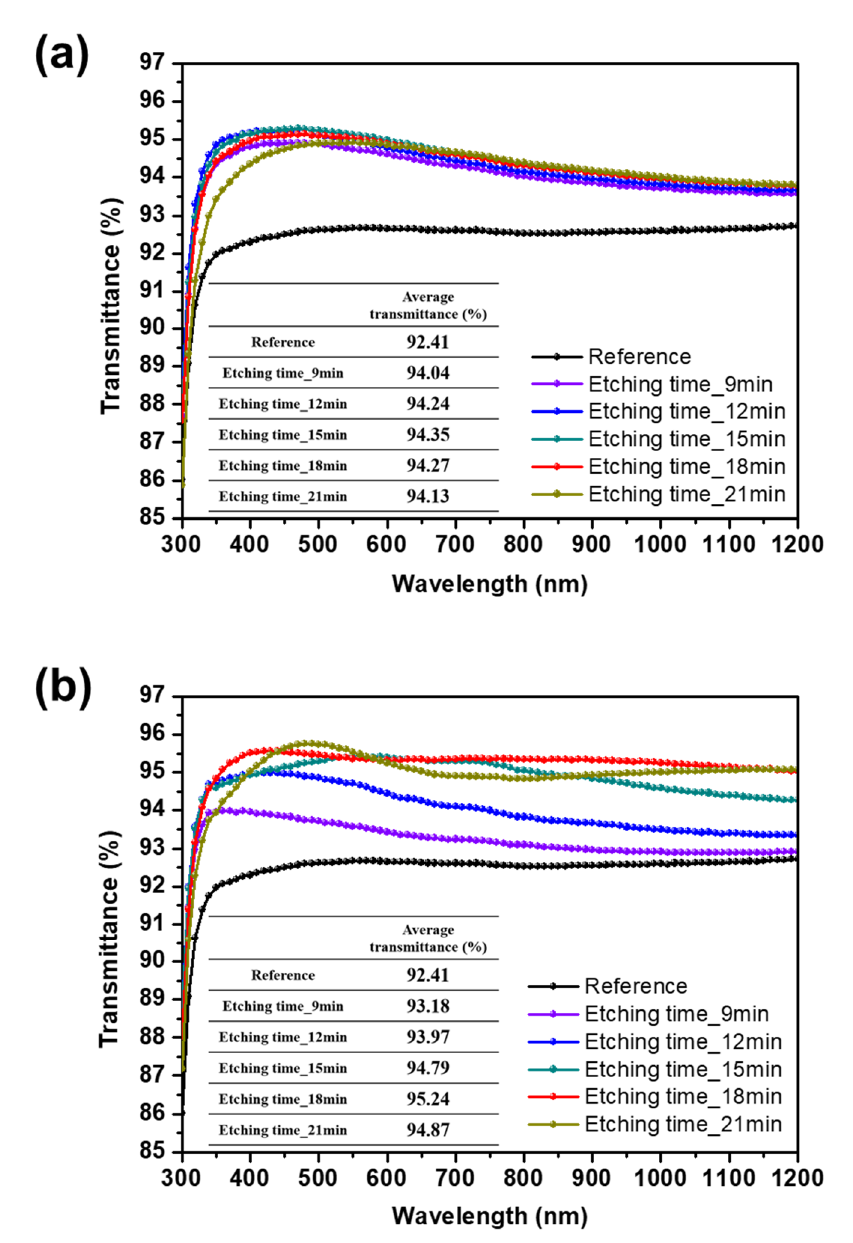
Figure 4. The measured transmittance spectra of the flat surface cover glass (reference) and SWS-integrated cover glass fabricated by ( a ) dry etching using the Ag nanoparticles and ( b ) the one-step self-masked etching with the etching time of 9–18 min.